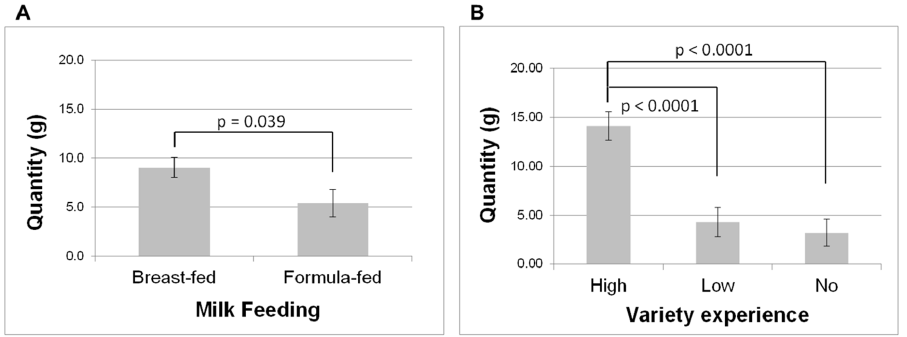
Fig 5. Early food-related variety experience is associated with higher intake of new vegetables. Intake (mean ± SE, in grams) at follow-up 3, i.e. when children were on average 6 years old. A: for breast-fed and formula-fed infants; B: for the three experimental groups (no, low and high variety).